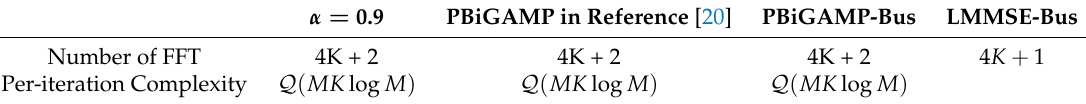
Table 1. Complexity Comparison Between The Investigated